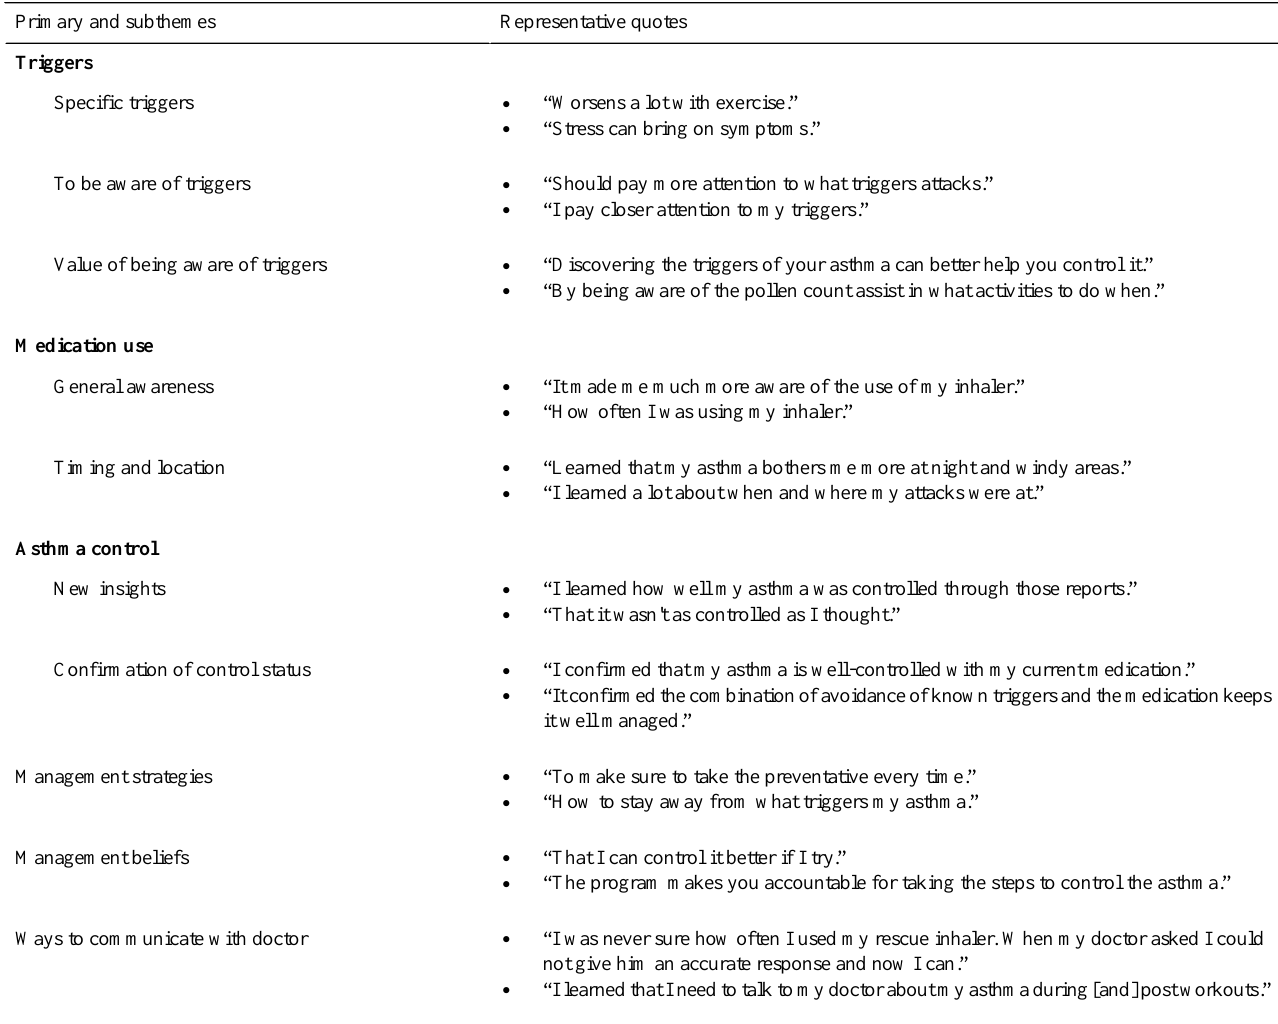
Table 5. Primary themes and subthemes of participant learnings as a result of the digital intervention.